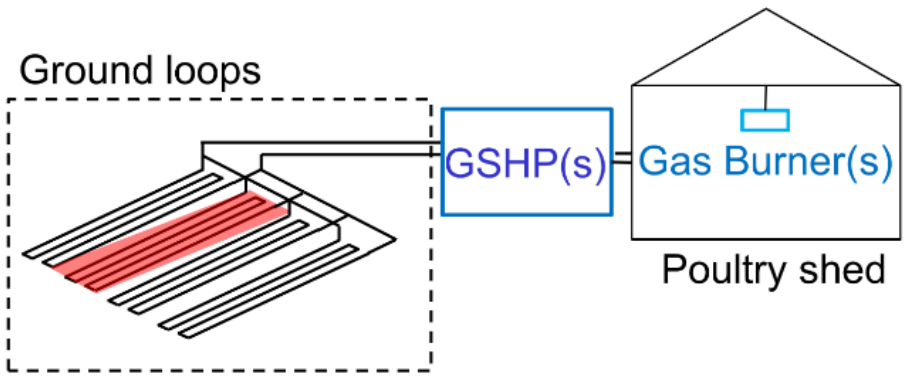
Figure 1. Diagram of the hybrid geothermal system for poultry sheds. Each trench is 75 m long and contains 300 m of HDPE pipes (highlighted in red).